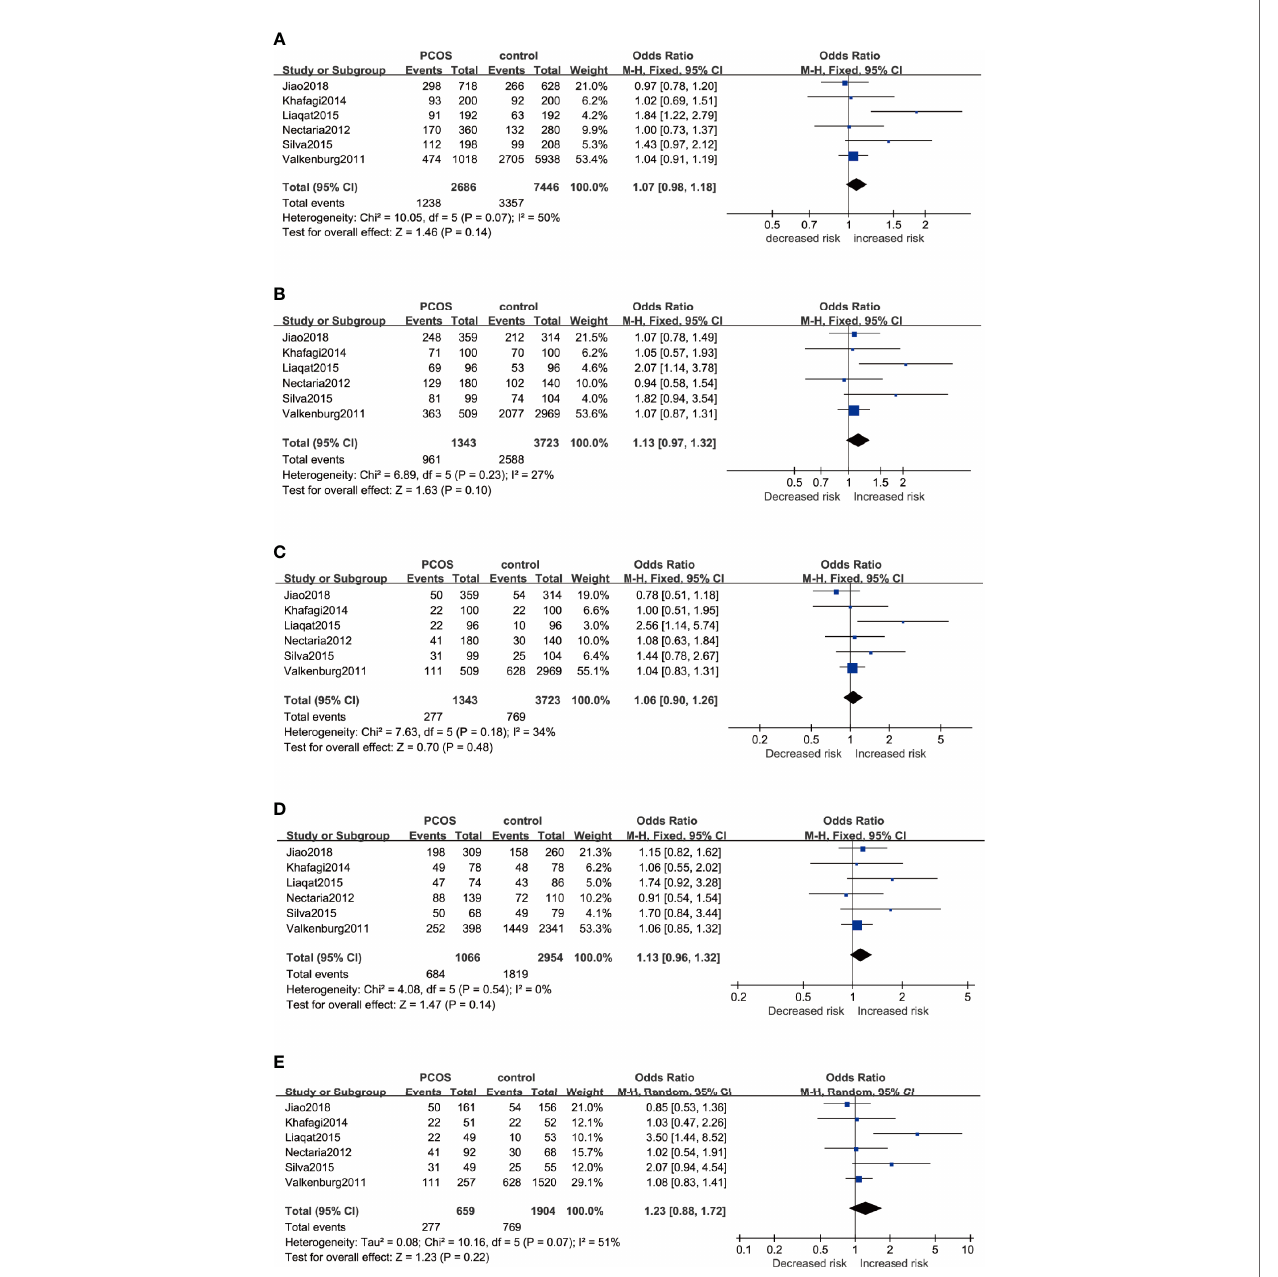
FIGURE 2 | Forest plots of the association between the ESR1 rs2234693 gene and risk of PCOS using different genetic models in overall analysis: (A) Allele model (C versus T), (B) Dominant model (CC+TC versus TT), (C) Recessive model (CC versus TT+TC), (D) Heterozygote model (TC versus TT), and (E) Homozygote model (CC versus TT). In each model, solid squares represent the OR, horizontal lines represent 95%CI, and diamond represents the pooled OR and 95%CI. OR, odds ratios; 95% CI, 95% con fi dence intervals; I 2 , inconsistency